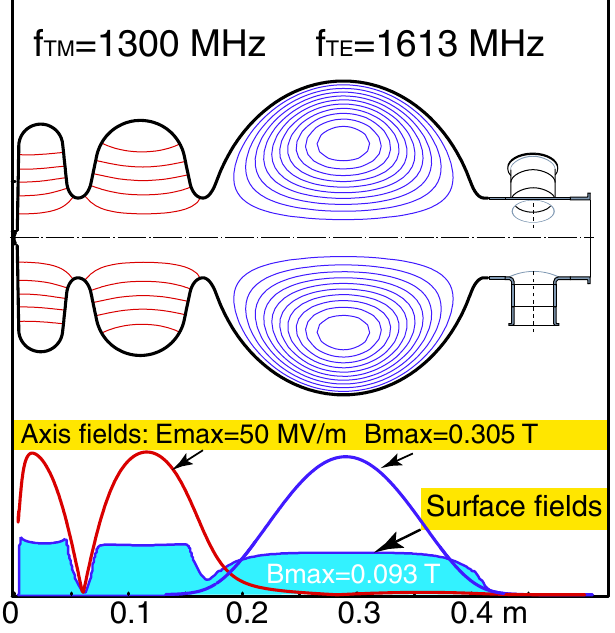
FIG. 3. (Color) Shape, field pattern, the axis, and surface fields cell superconducting cavity of the rf gun with the separated of 1 1 2 focusing TE mode having the frequency of 1613 MHz. 011